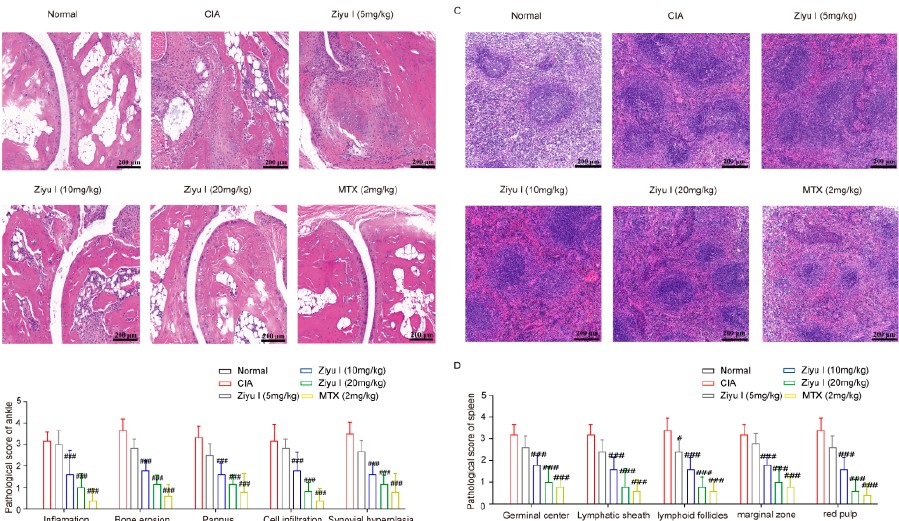
Figure 2. Effects of different doses of Ziyu I on the histopathology of ankles and spleens of CIA mice. ( A ). Representative pathological images of ankles. ( B ). Analysis of pathological ankle scores. ( C ). Representative pathological images of the spleen. ( D ). Analysis of pathological spleen scores. The data were expressed as mean ± SD, n = 5. # p < 0.05, ### p < 0.001 vs. CIA.